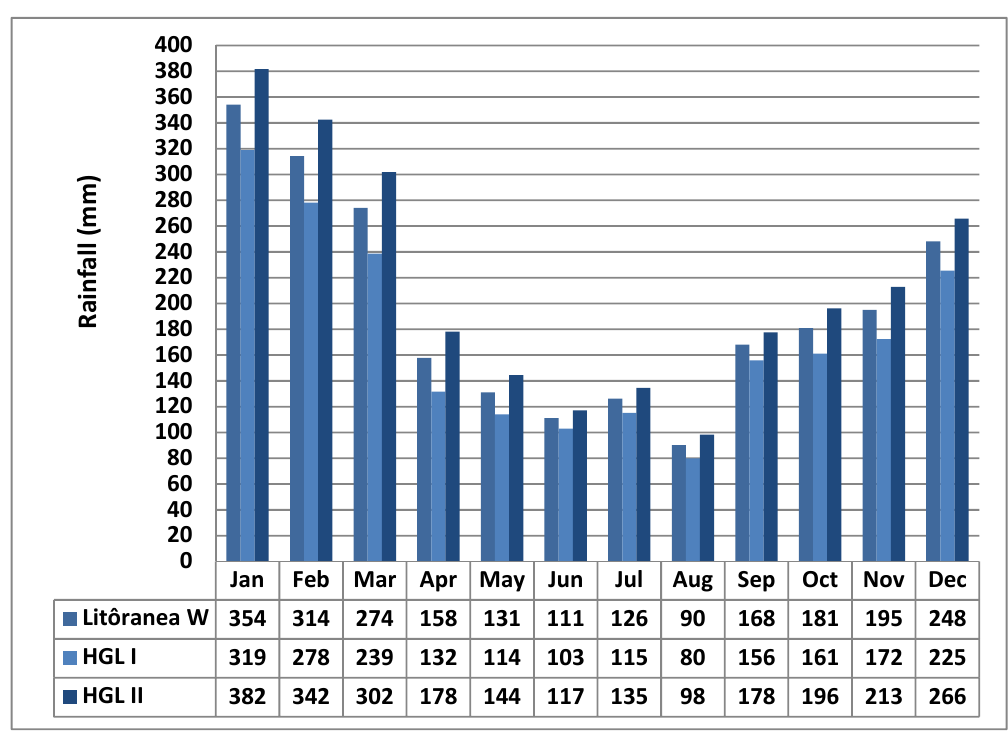
Figure 8. Average monthly rainfall (mm) for the homogeneous groups (HG) in the Litorânea watershed (W), Paraná, Brazil.